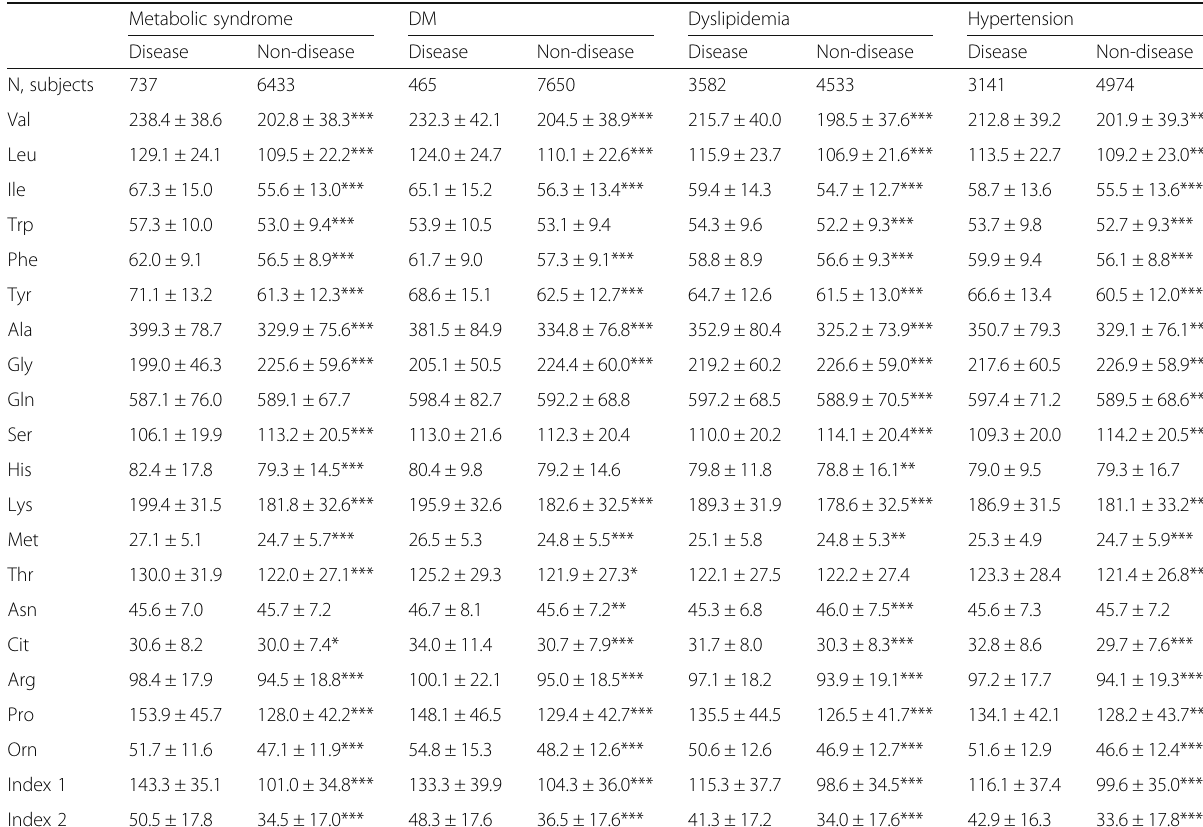
Table 2 Plasma free amino acid concentrations ( μ mol/L) and index values in the study population. The values are shown as means ± standard deviations Metabolic syndrome DM Disease Disease Disease